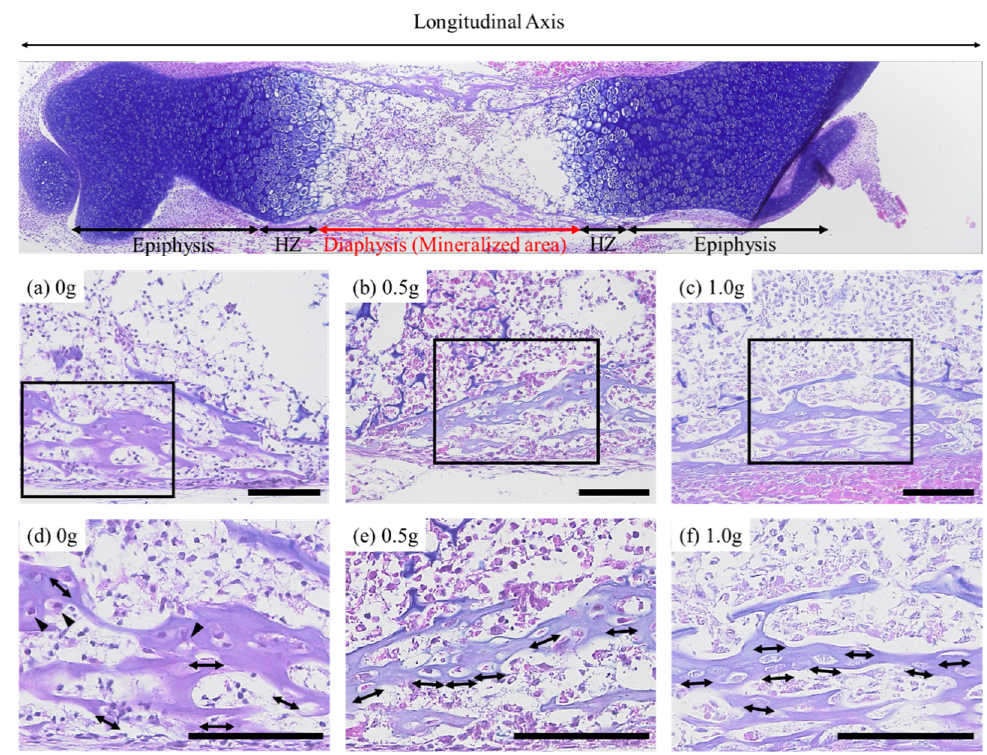
Figure 4. Histological image stained with Alcian Blue and HE of entire bone and the magnified images in the diaphysis of ( a ) 0 g, ( b ) 0.5 g and ( c ) 1.0 g, and ( d – f ) magnified images of the boxed regions. Arrowheads indicate spherical osteocytes. Arrows indicate the elongation of osteocytes. Scale bars: 100 mm.